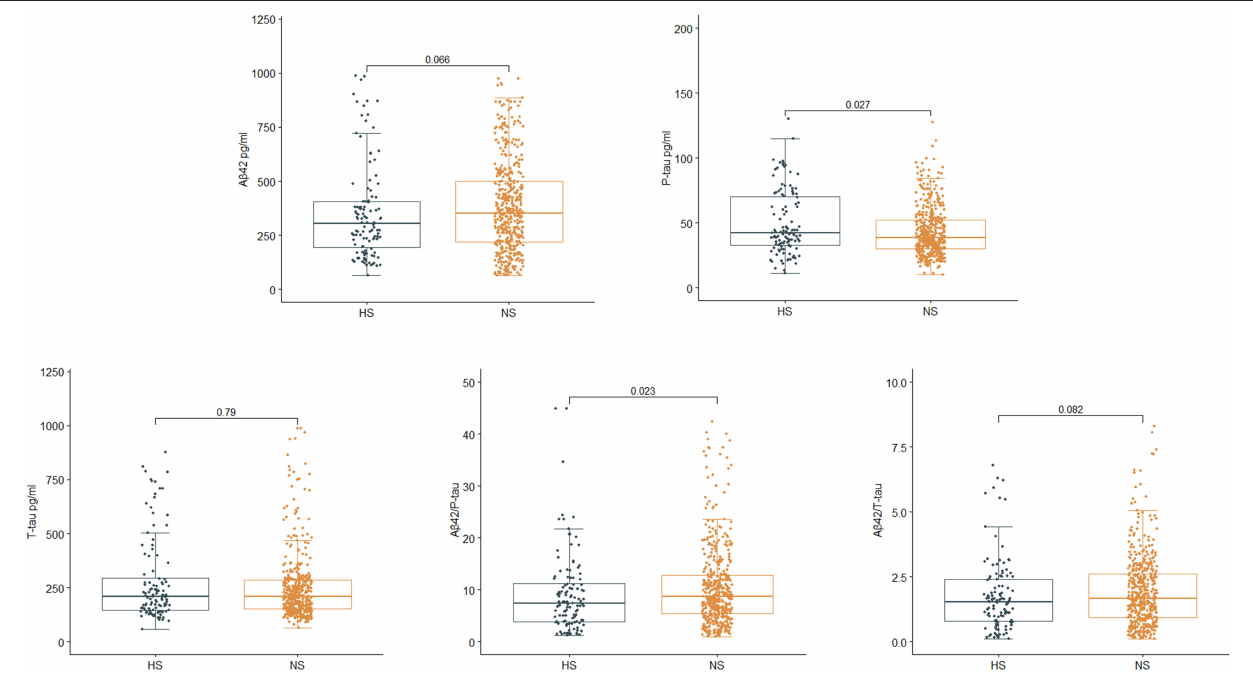
FIGURE 2 | Relationship between serum uric acid (SUA) and cerebrospinal fluid (CSF) Alzheimer-related biomarkers in PNDABLE. CSF phosphorylated tau (P-tau) was positively correlated with SUA ( p = 0.027), while CSF A β 42 /P-tau was negatively correlated with SUA ( p = 0.023).